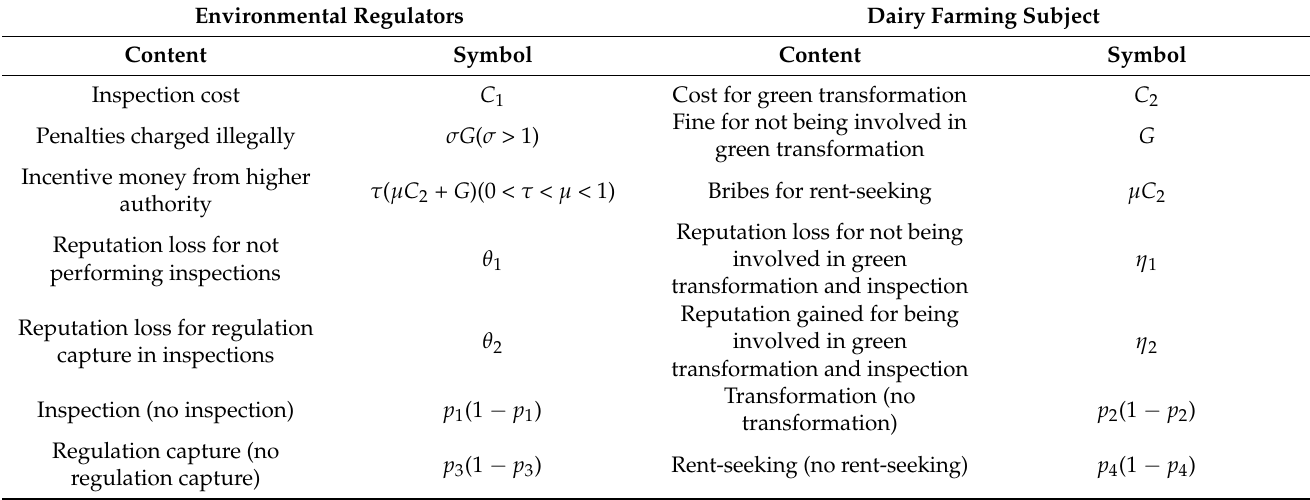
Table 2. The symbols and meanings of the variables in the dynamic game between environmental regulators and dairy farming